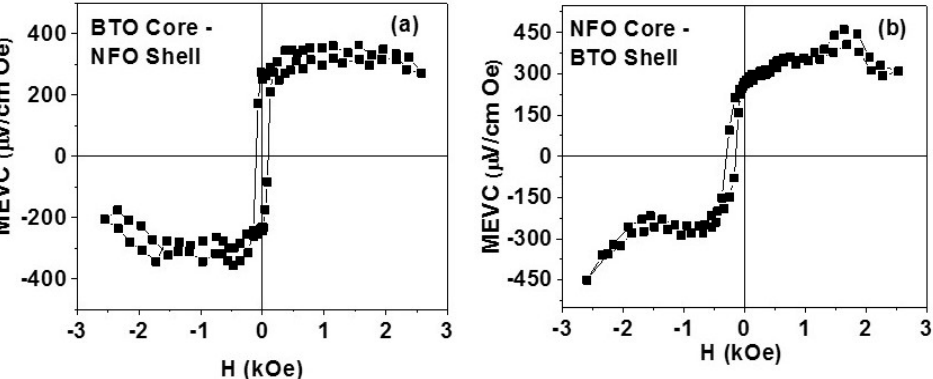
Figure 7. Low-frequency ME voltage coefficient measured in magnetic field-assembled films of ( a ) sample A and ( b ) sample B.